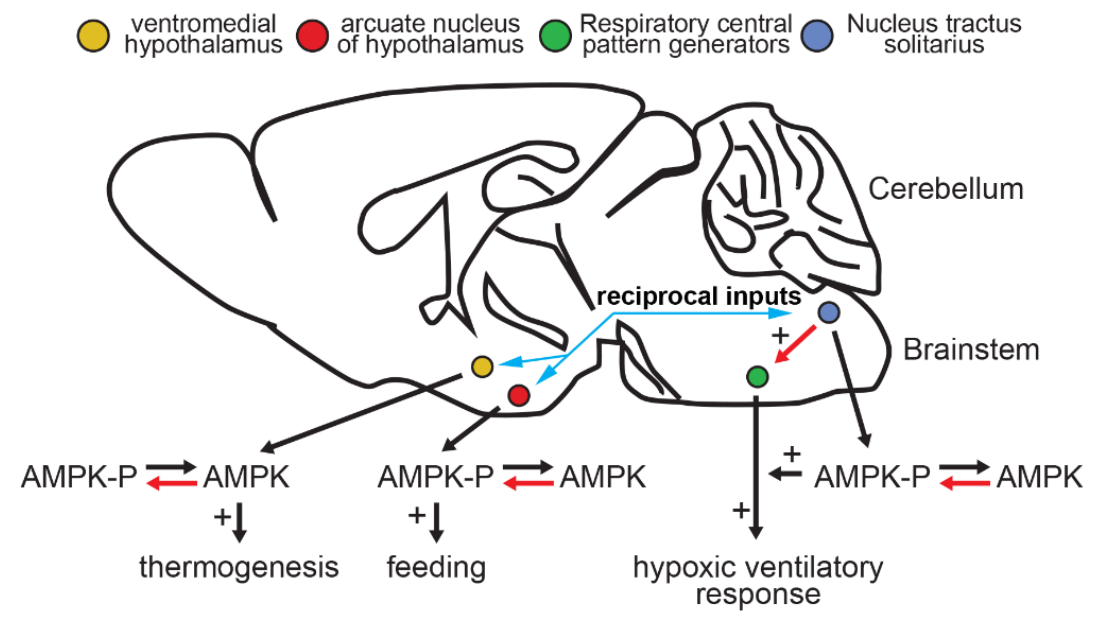
Figure 4. When the clock strikes four feed and breathe some more. The diagram shows a tracing of a sagittal section of a whole mouse brain, indicating anatomical locations where AMPK may regulate the neural control of appetite / feeding (arcuate nucleus), energy expenditure (ventromedial hypothalamus) and breathing nucleus tractus solitarius (NTS) + respiratory central pattern generators (rCPG). Red arrows indicate pathway to AMPK, or rCPG activation. Black arrows indicate pathways to increased breathing, feeding and thermogenesis. Blue arrows indicate reciprocal pathways of innervation between the NTS, arcuate nucleus and ventromedial hypothalamus. Created by Evans and